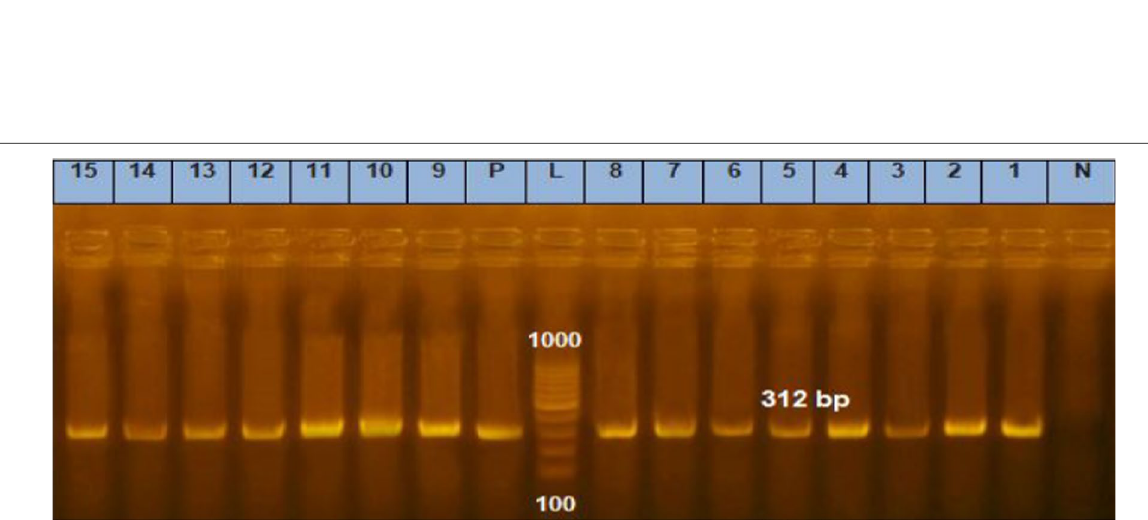
Fig. 13 Agarose gel electrophoresis showing amplification product of 312 bp of AcrAB . Lane L : Ladder (Marker) 100‑1000 bp plus DNA ladder. Lane P : control positive. Lane N : control negative. Lane 1–15 : examined